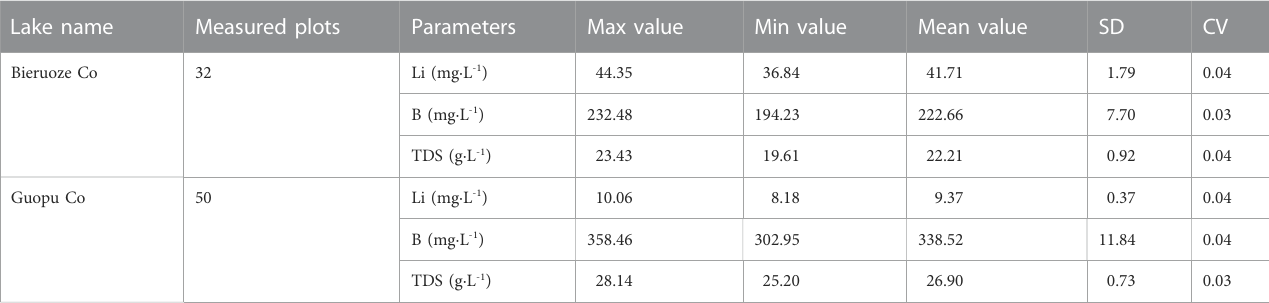
TABLE 1 Statistical information on the measured values of all the sampling points of Bieruoze Co and Guopu Co. Lake name Measured plots Parameters Bieruoze Co